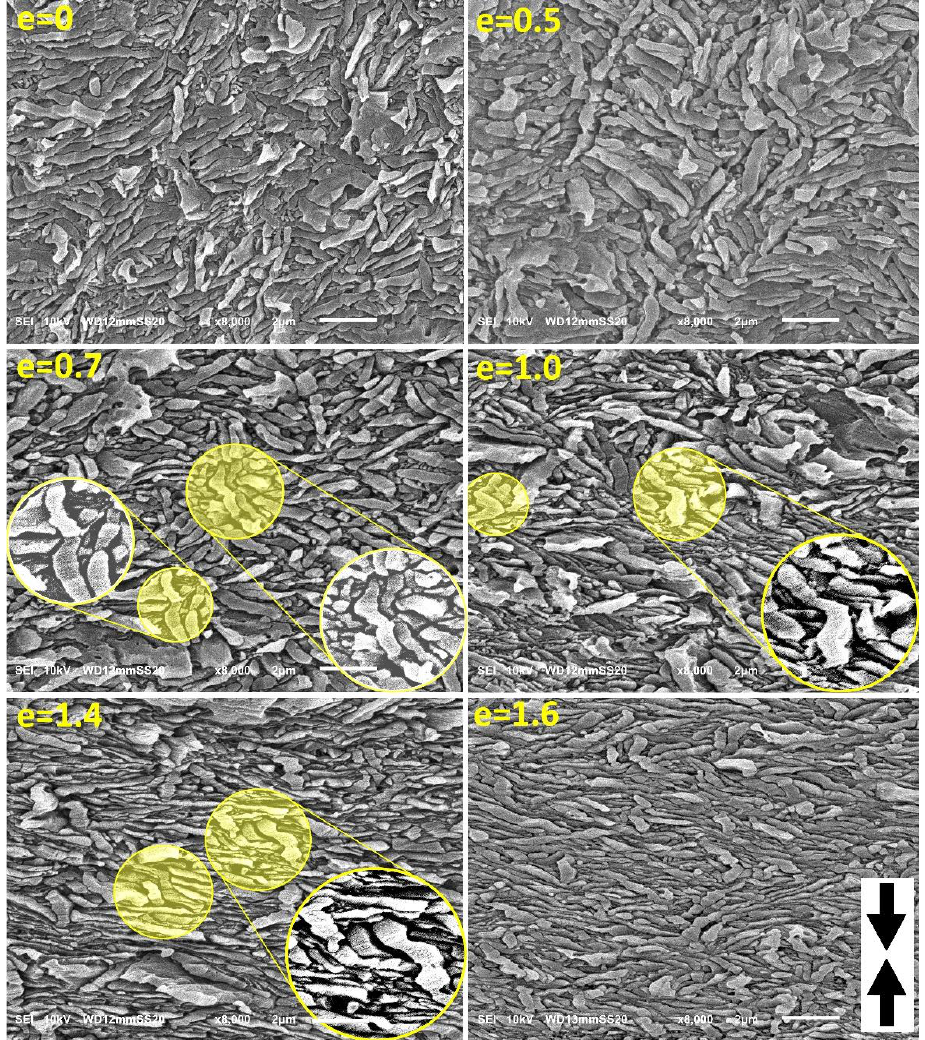
Figure 7. SEM micrographs of the H5-CE samples deformed by uniaxial compression to the true strain indicated. The direction of compression is vertical. Circular insets show enlarged details. Note, that the magnification is higher than that of the micrographs in Figures 5 and